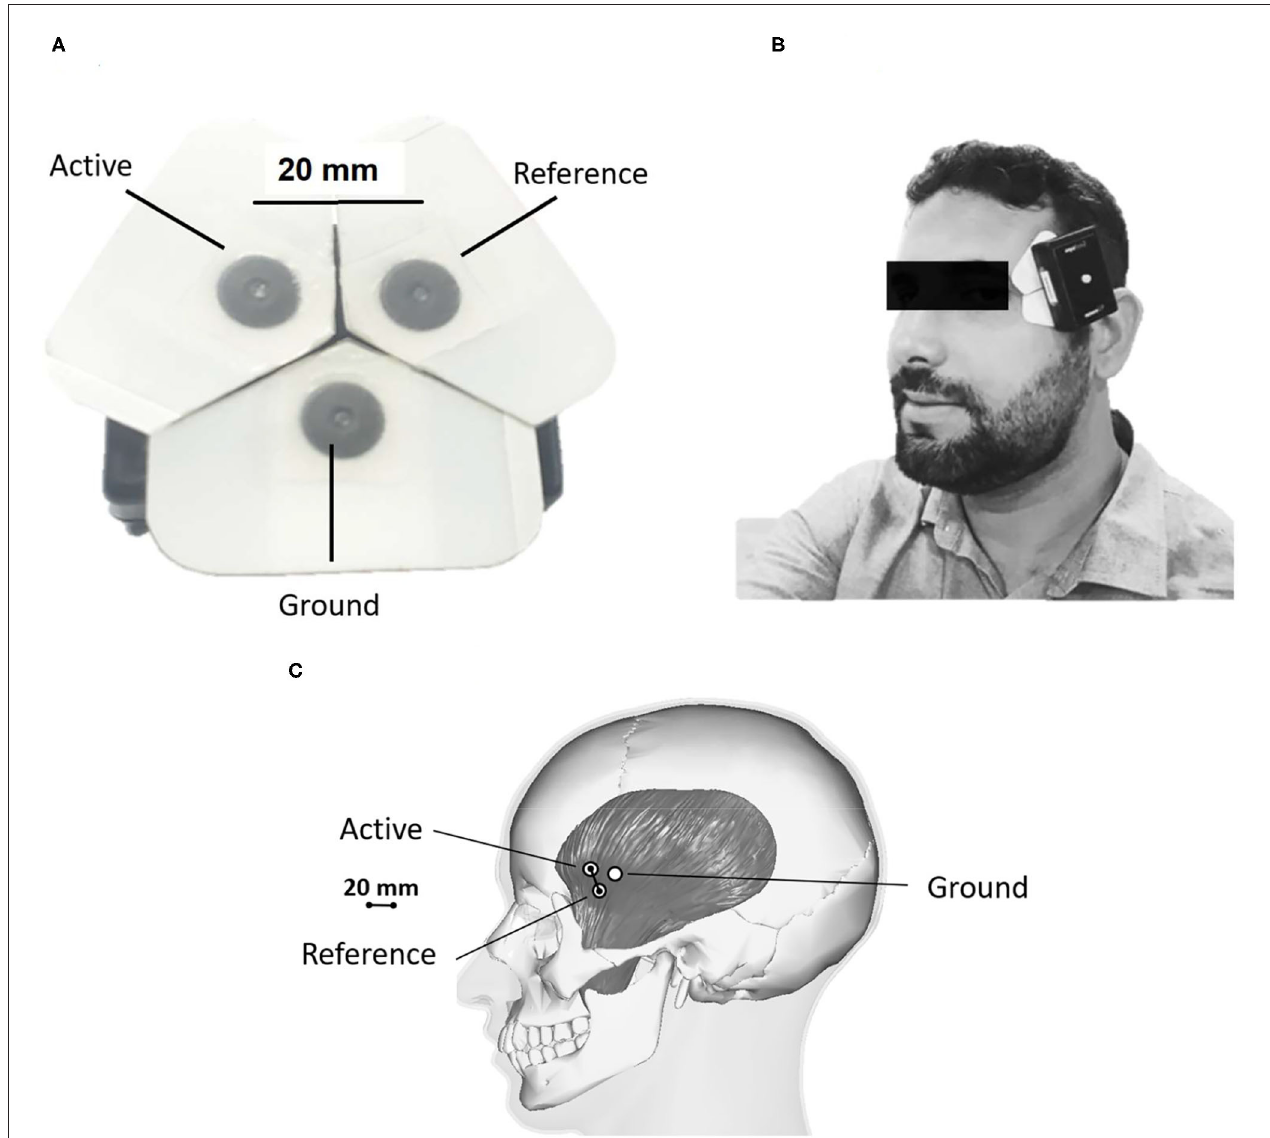
FIGURE 1 | Electrode placement. (A) Arrangement of adhesive EMG electrodes; (B,C) Positioning of the EMG equipment over the anterior portion of the temporal muscle; The difference between electrodes (20mm) allows them to be used in volunteers irrespective of age and sex. The white paper surrounding the electrodes can be cut if necessary to fit different head